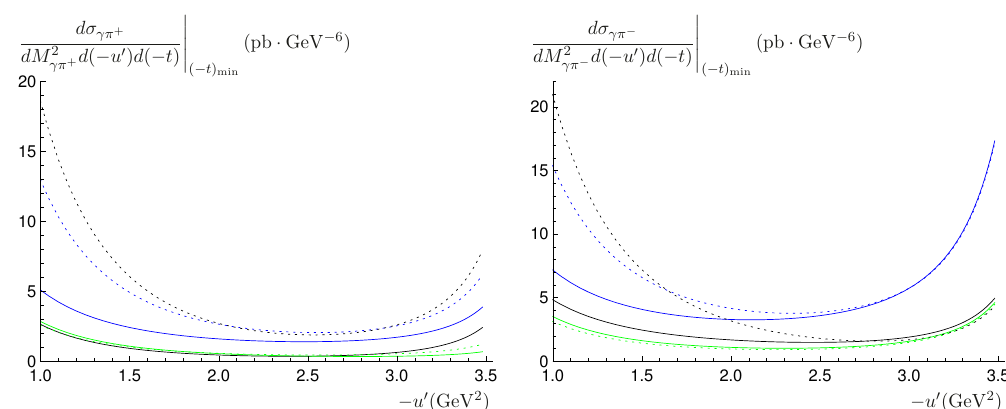
Figure 3 . Left: differential cross section for the production of a photon and a π + meson on a proton target. Right: differential cross section for the production of a photon and a π − meson on = 4 GeV 2 , S γ N = 20 GeV 2 , t = ( t ) min as a a neutron target. Both cross-sections are at M 2 γπ − − function of u ′ . In black the full result, in blue the contributions of the u quark GPDs H u and ˜ H u − only, and in green the contributions the contributions of the u quark GPDs H d and ˜ H d only. Solid: “valence” model, dotted: “standard”